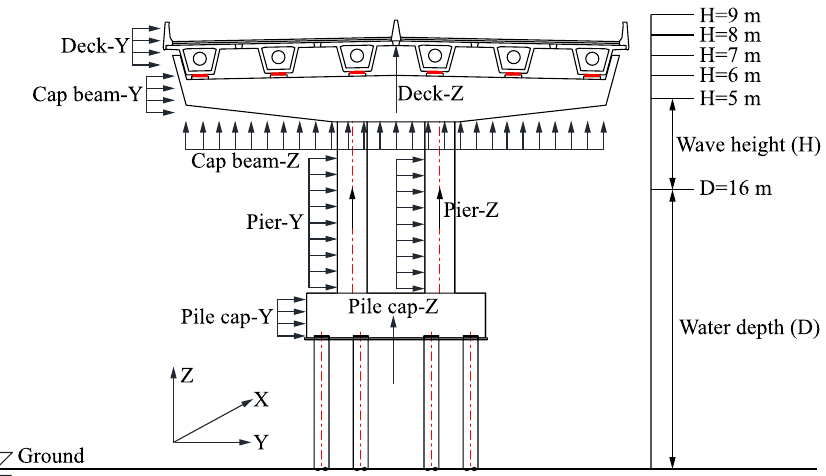
Fig. 5 Schematic diagram of the tsunami loading application and analysis scenarios